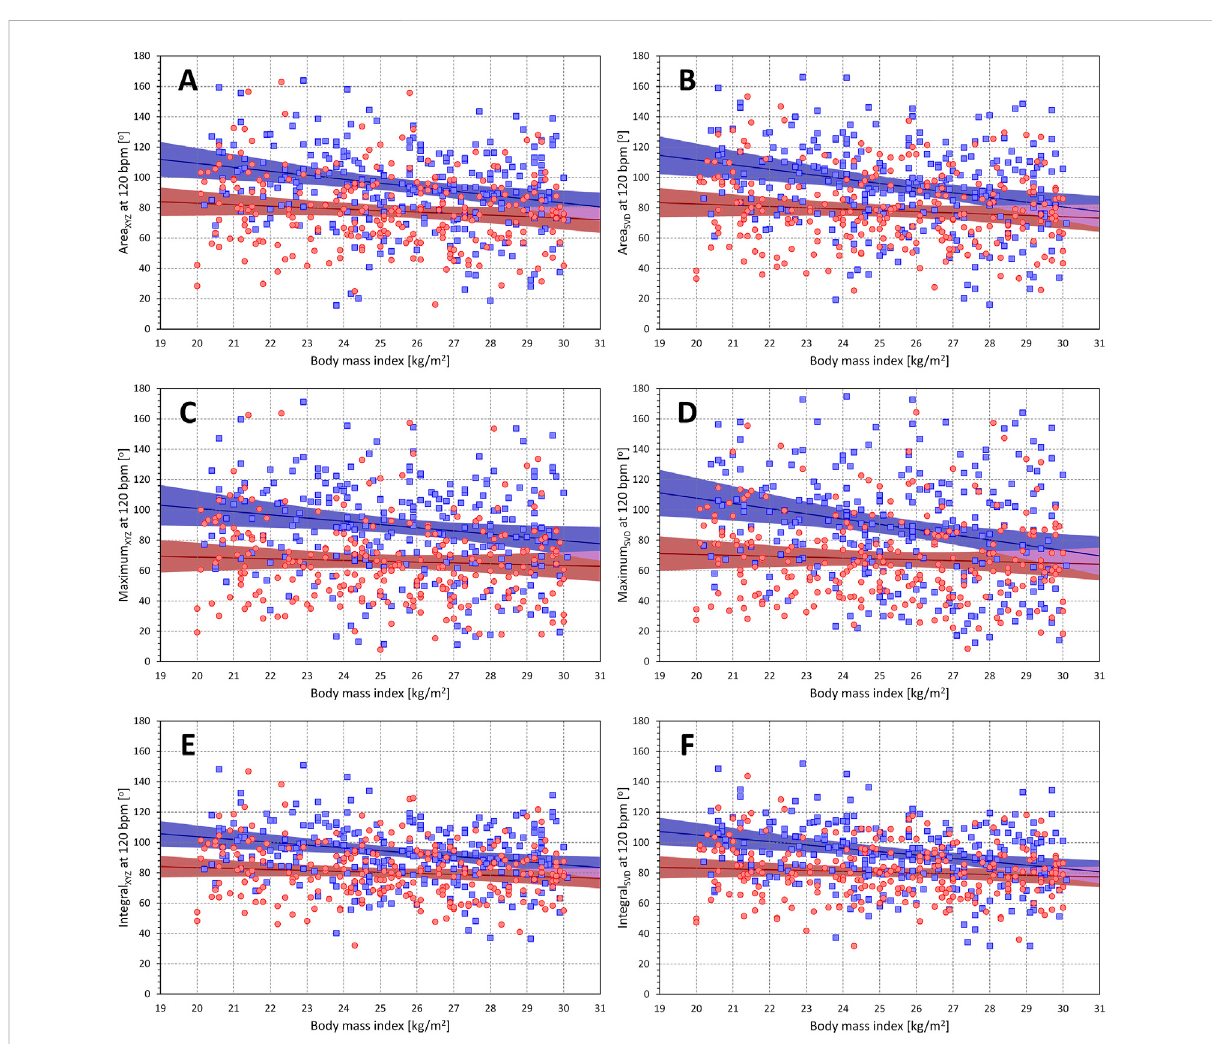
FIGURE 13 RelationshipofQRS-Tangle(projectionstoheartrateof120 bpm)tobodymassindex.Thedifferentpanelsofthe fi gure showscatterdiagrams between body mass index and subject-speci fi c projections of different QRS-T angle expressions to the heart rate of 120 bpm. The layout of the fi gure and the meaning of the individual symbols is the same as in Figure